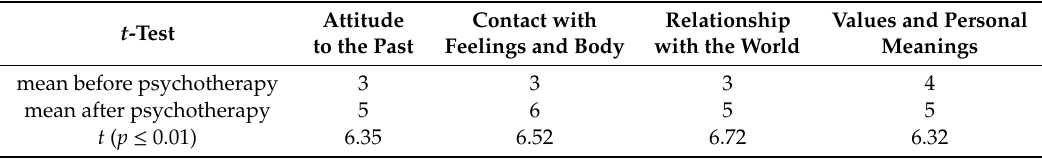
Table 6. The t -test on indicators of de-sedimentation of